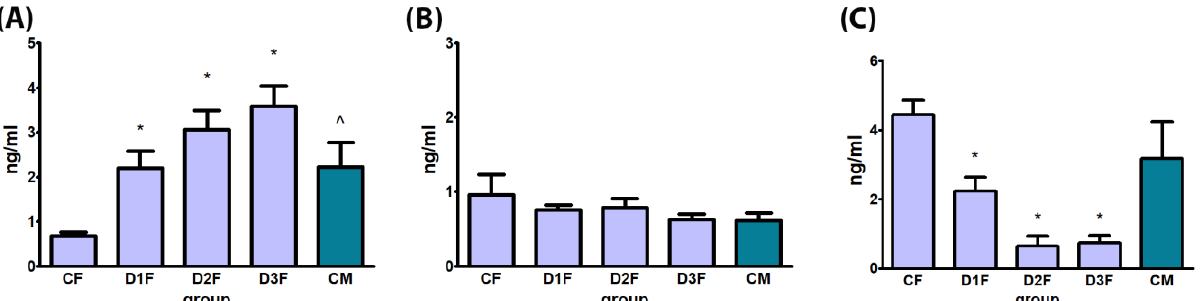
Figure 5. Biochemical evaluation of hormones by ELISA of female rats subcutaneously treated with different doses of testosterone enanthate two times a week, for 2 weeks: CF: 0—sesame oil, D1F: 0.45, D2F: 0.95, D3F: 2.05 and CM (control male) 0 mg. Panel ( A ) testosterone, ( B ) estradiol, ( C ) luteinizing hormone. Data are presented as mean ± standard deviation. Statistical significance: * p < 0.05 “CF” vs. “DF” groups; * p < 0. “CM” vs. “DF” groups; ˆ p < 0.05 “CF” vs. “CM” groups Mann–Whitney test.